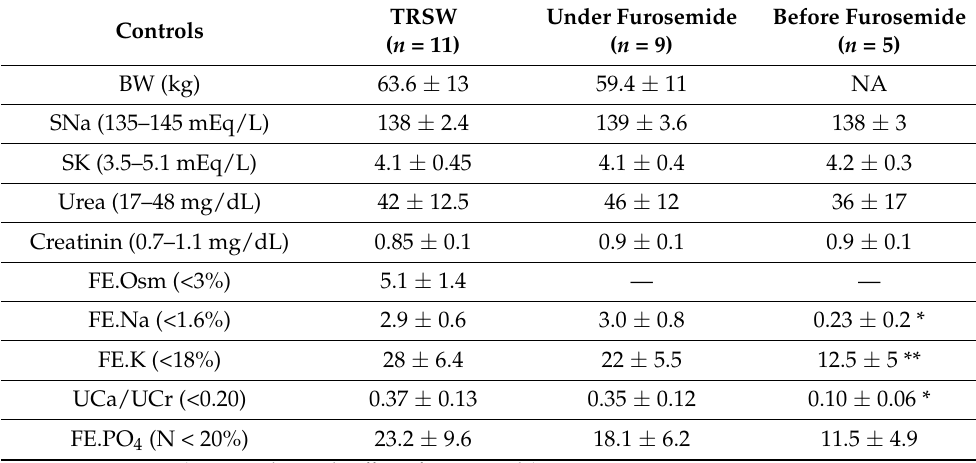
Table 3. Some serum and urine parameters in patients with transient renal salt wasting (TRSW) ( n = 11) compared to patients with cardiac failure before ( n = 5) and after early oral intake of 40 mg furosemide ( n =